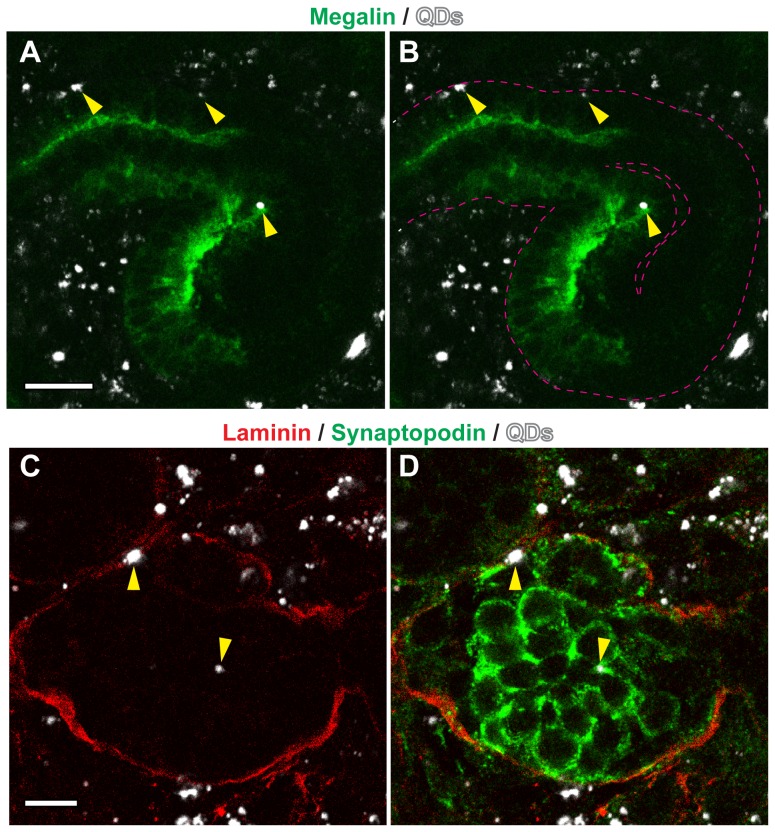
KSCs generate proximal tubule cells and podocytes within the developing nephrons.(A, B) Chimeric organoids were stained for megalin (green). Arrowheads indicate QD-labeled (white), megalin+ KSCs within a nascent proximal tubule. Note that megalin is present on the apical surface of the nascent proximal tubule (dotted lines in B), thus recapitulating its normal expression pattern observed in vivo. (C, D) Chimeric organoids were stained for synaptopodin (green) and laminin-111 (red). Arrowheads point to QD-labeled (white), synaptopodin+ KSCs within a nascent glomerulus. Scale bars are 20 µm (A, B) and 8 µm (C, D).